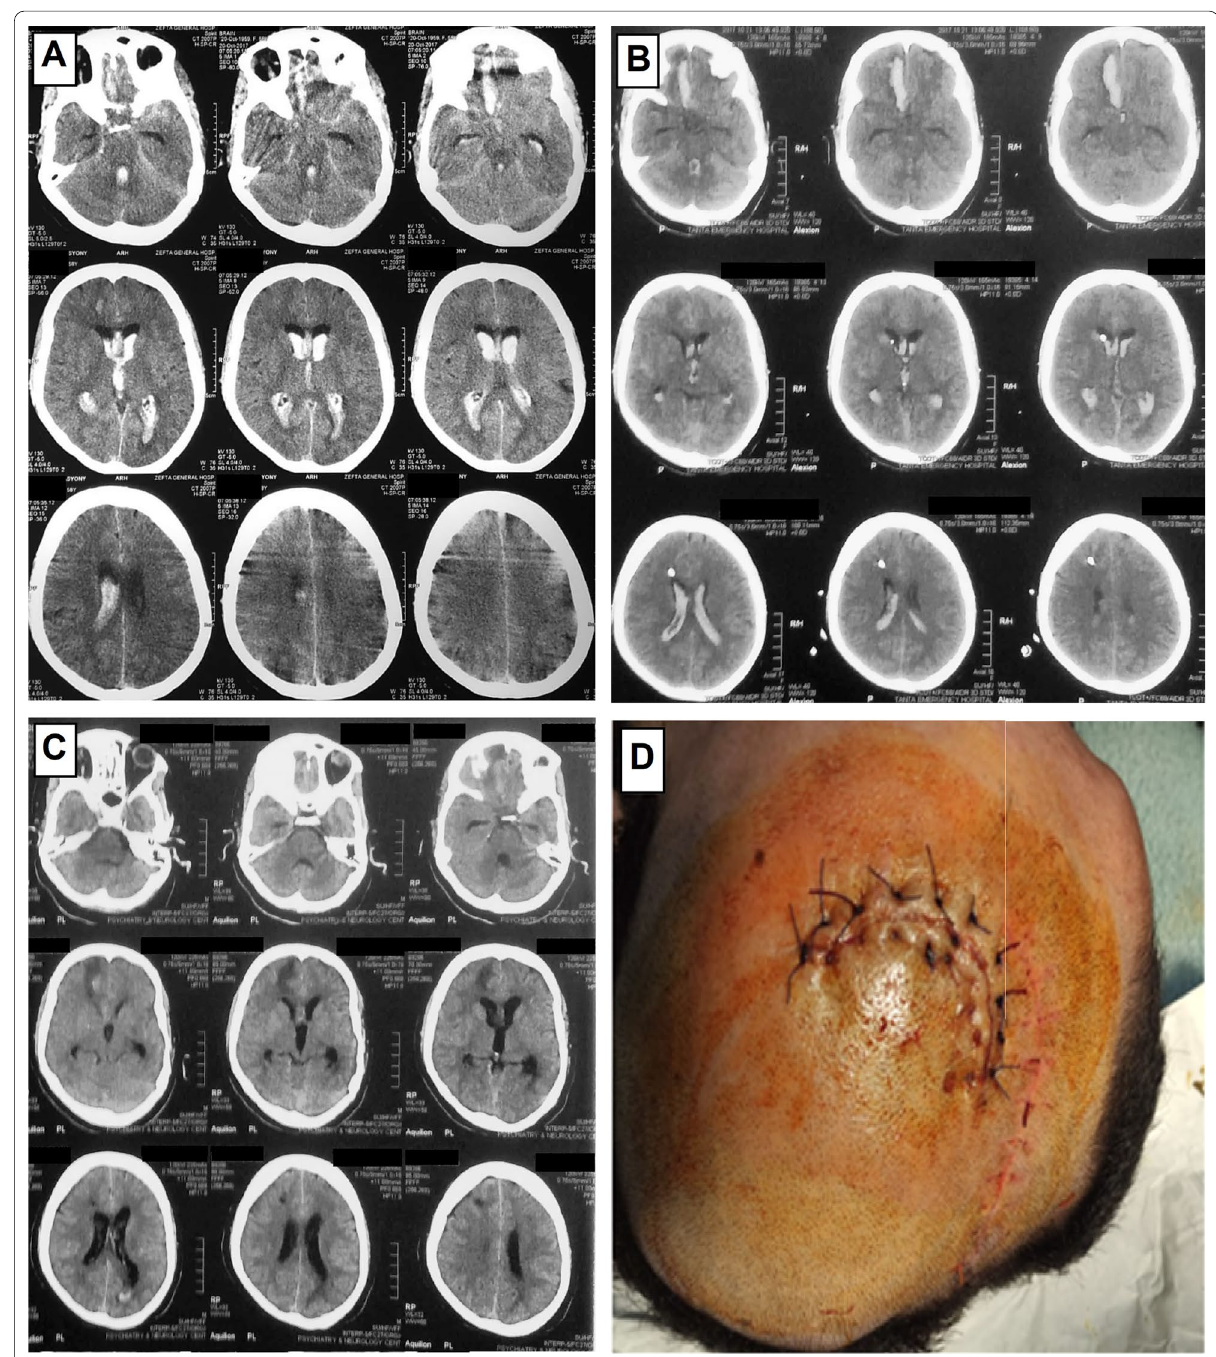
Fig. 2 A 51-year-old male presented with intraventricular haemorrhage managed by right-sided ventriculosubgaleal shunt (VSGS). A Axial CT scan before insertion of shunt shows blood is filling and dilating both lateral ventricle, third and fourth ventricles with right sub-frontal intra-cerebral haematoma. According to Graeb’s grading system, intraventricular haemorrhage is graded as severe with score 12. B and C Axial CT scan 24 h and 7 days, respectively, after VSGS insertion showing the end of the shunt inserted into the frontal horn of the right lateral ventricle with progressive decrease in the intraventricular blood (successful drainage) and decrease ventricular dilatation. D Postoperative image of patient’s head showing bogginess of the scalp with CSF post-insertion of VSG shunt using C-shaped incision at Kocher’s